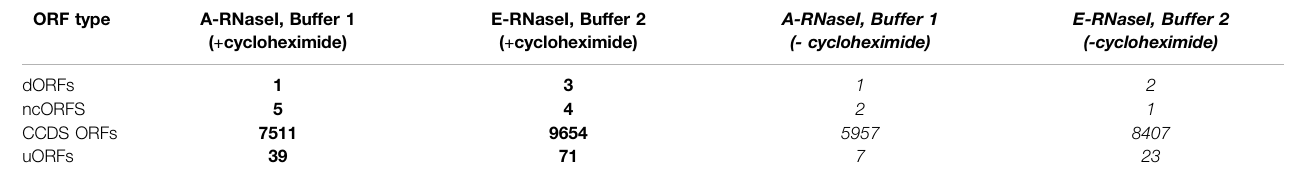
TABLE 3 | Summary of translated ORFs identifed in Drosophila S2 cells. ORF